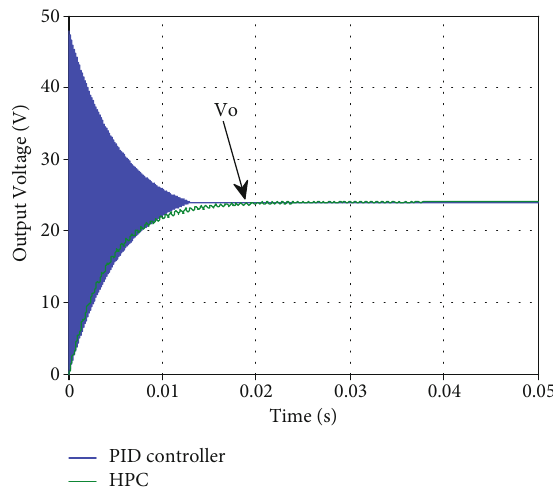
Figure 16: Simulated response of V and load R = 5 : 76 Ω : Table 2: Variations with HPC for K = 15 , T λ = 0 : 978 , R = 5 : 76 Ω , V